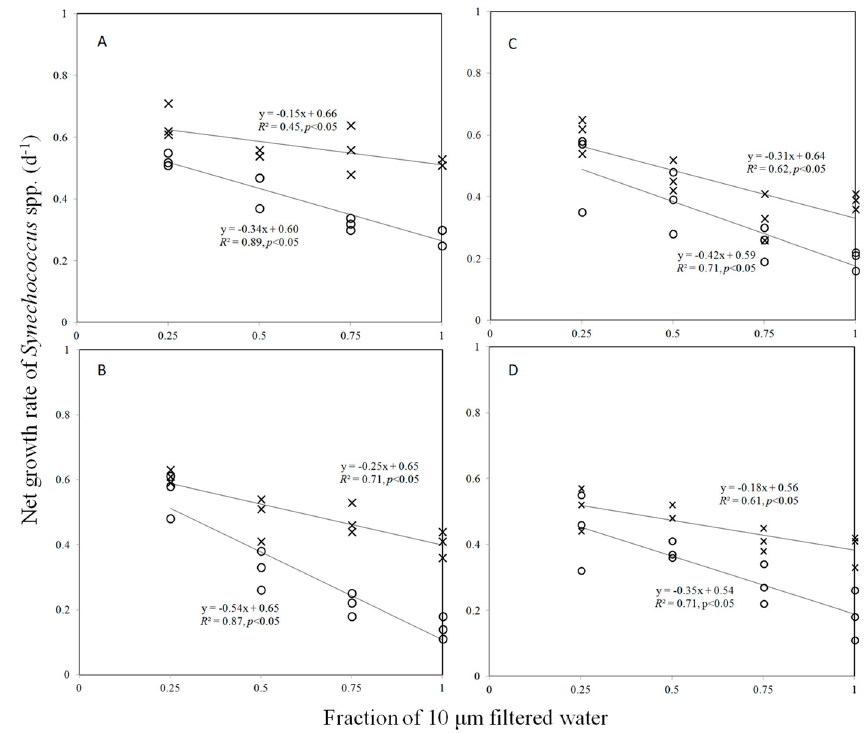
Figure 1. Dilution plots of Synechococcus spp. net growth rate (day − 1 ) versus the fraction of 10 μ m filtered water in early ( A ), the end of July ( B ), August ( C ), and September ( D ). Open circles and cross marks represent the net growth rates in the in situ condition and nutrient-enriched treatments, respectively. Table 1. Surface in situ water temperature, nutrients at the sampling site, and enriched incubations at the beginning of experiments. Growth and nanoflagellate grazing rates upon Synechococcus spp. estimated by linear regression of dilution experiments under in situ and nutrient-enriched conditions conducted during the study period. a : Percentage of difference of grazing rate between nutrient enriched and in situ condition.